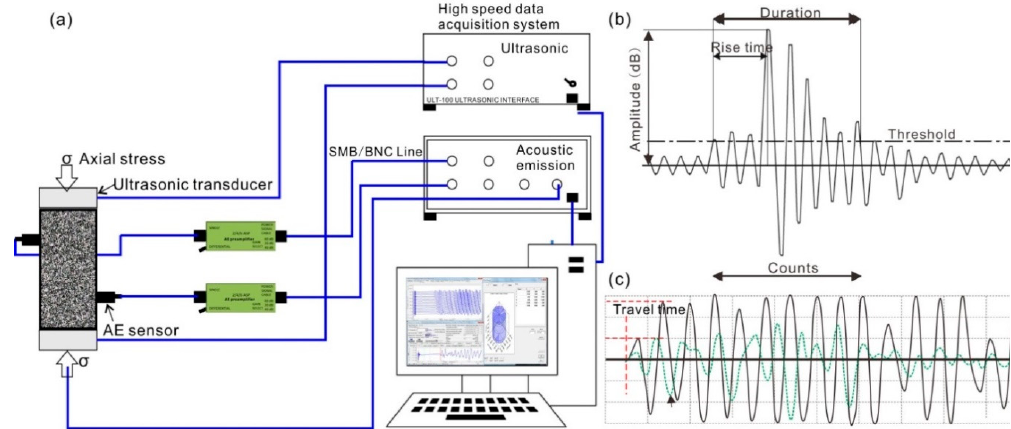
Figure 4. Scheme of the ultrasonic detection and AE monitoring principle during sample deformation. ( a ) Connection of the AE device to the sample; ( b ) determination of AE parameters from the waveform; ( c ) ultrasonic waveform to get the travel time.